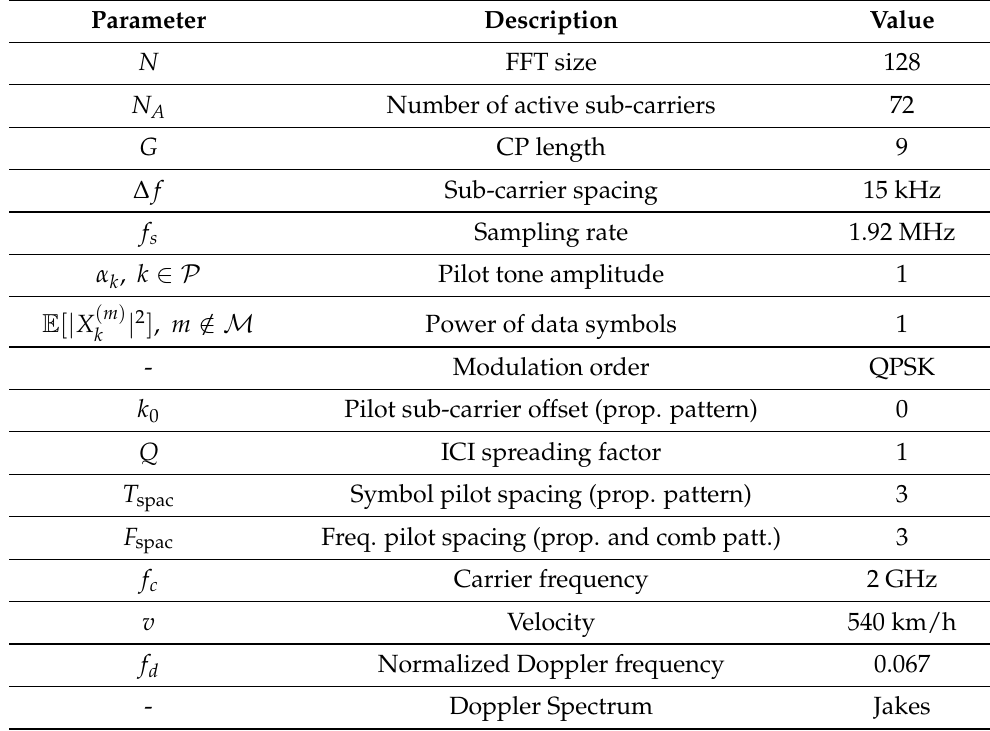
Table 1. Simulation parameters.